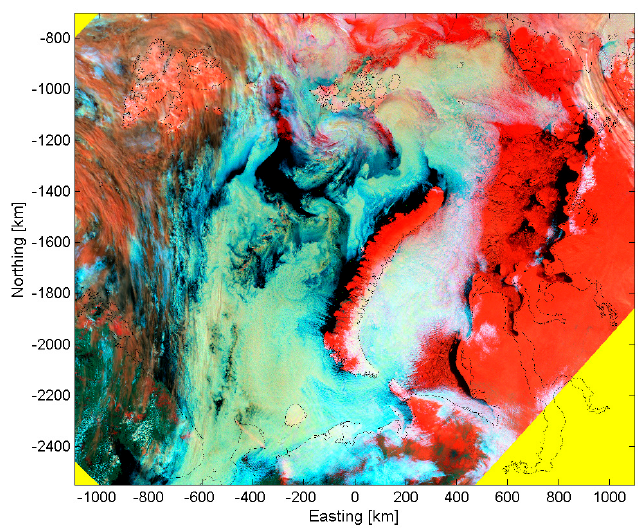
Figure 15. MODIS RGB-image from bands 3-6-7 on 12 May 2016, 09:30 UTC.